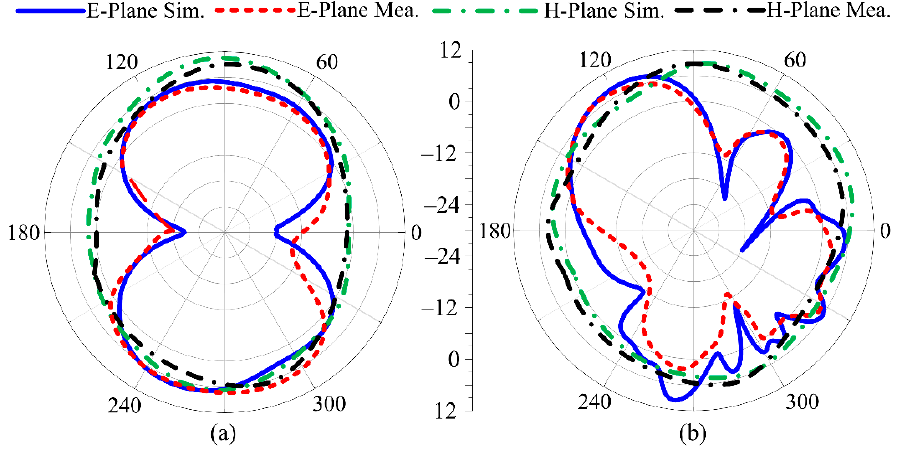
Figure 13. Predicted and measured radiation pattern of suggested UWB antenna with FSS at ( a ) 8 GHz; ( b ) 13 GHz.